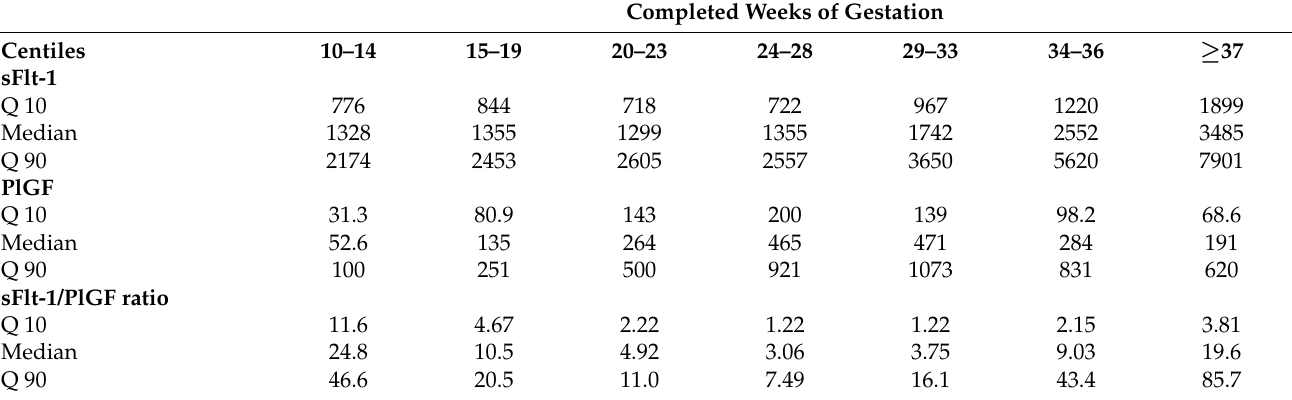
Table 1. Serum values of sFlt-1 (pg/mL), PlGF (pg/mL), and sFlt-1/PlGF ratio in patients with a normal singleton pregnancy. The median as well as the centiles (Q) 10 and 90 are shown—data from Roche study No. CIM RD000556/X06P006